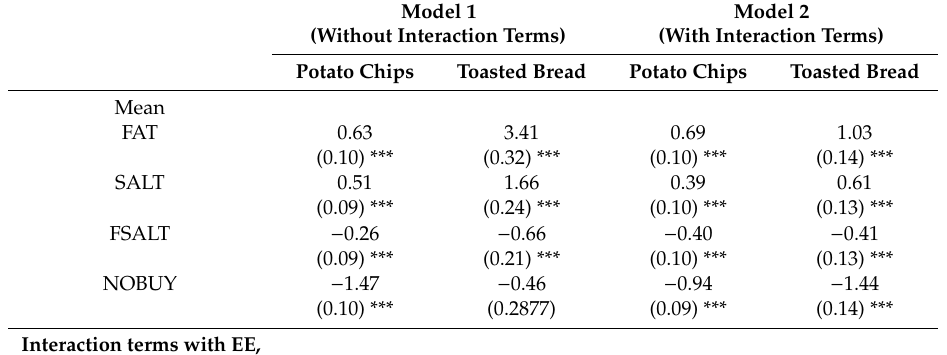
Table 3. Estimates from the Mixed Logit Models in willingness-to-pay (WTP)-Space ( € / package of